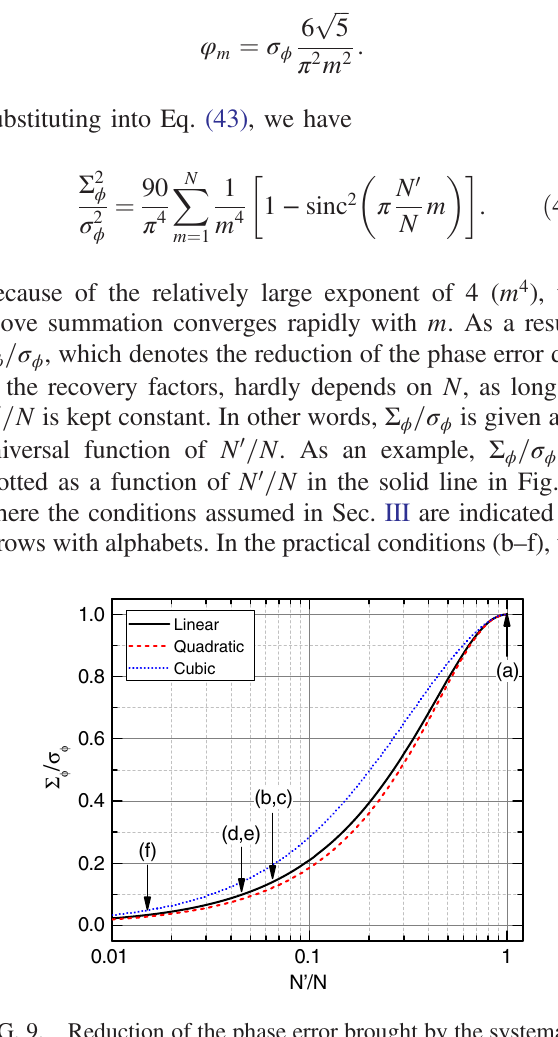
FIG. 9. Reduction of the phase error brought by the systematic errors due to the recovery factors represented by N=N 0 ; the solid, dashed, and dotted lines correspond to the linear, quadratic, and cubic variations of the magnetic